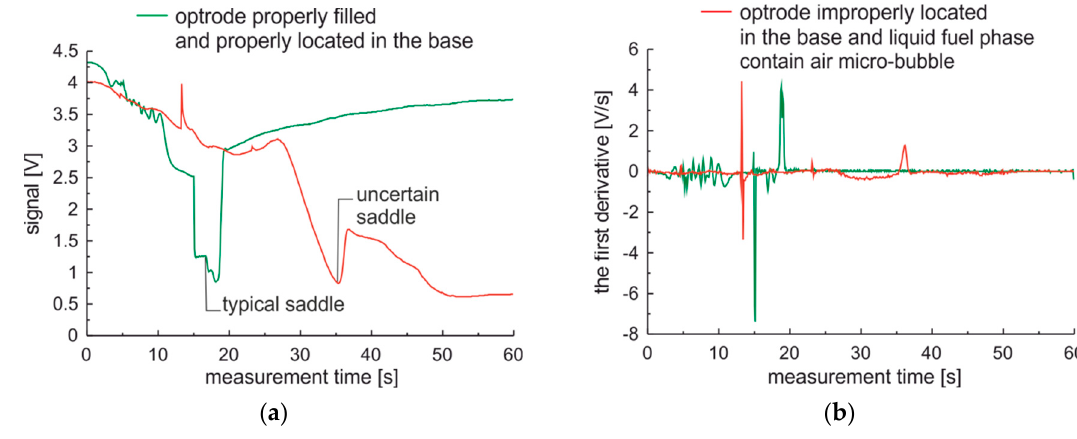
Figure 11. Measurement series of standard fuel for optrode properly prepared for examination and